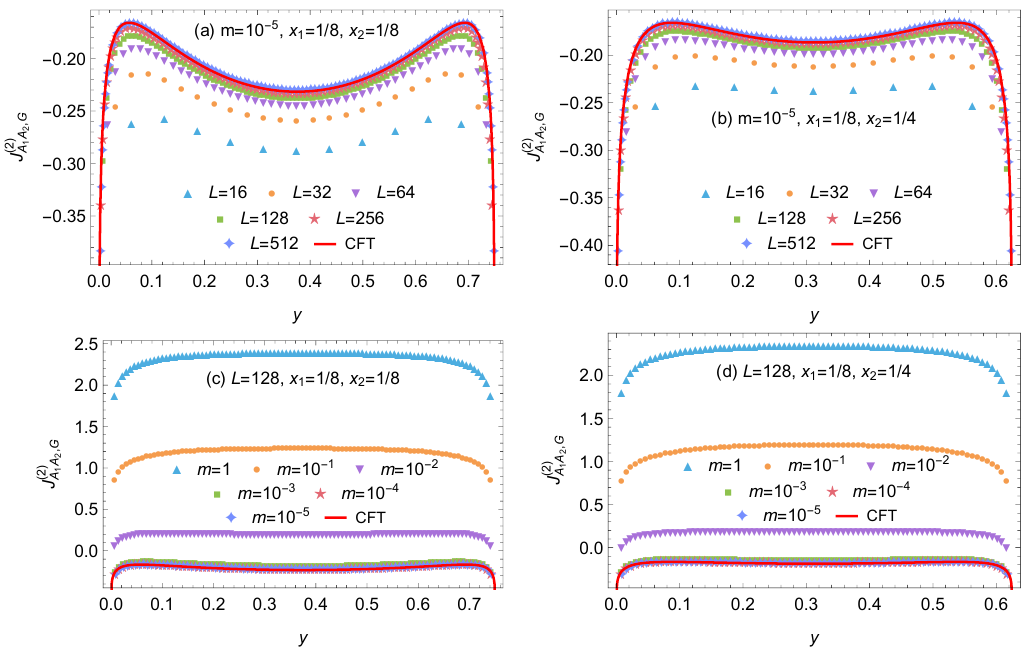
Figure 6 . The second Rényi mutual information in ground state of the harmonic chain in the continuum limit and the massless limit. We verify (6.8). Especially, we verify the IR divergent term in the ground state double-interval Rényi entropy (6.6).